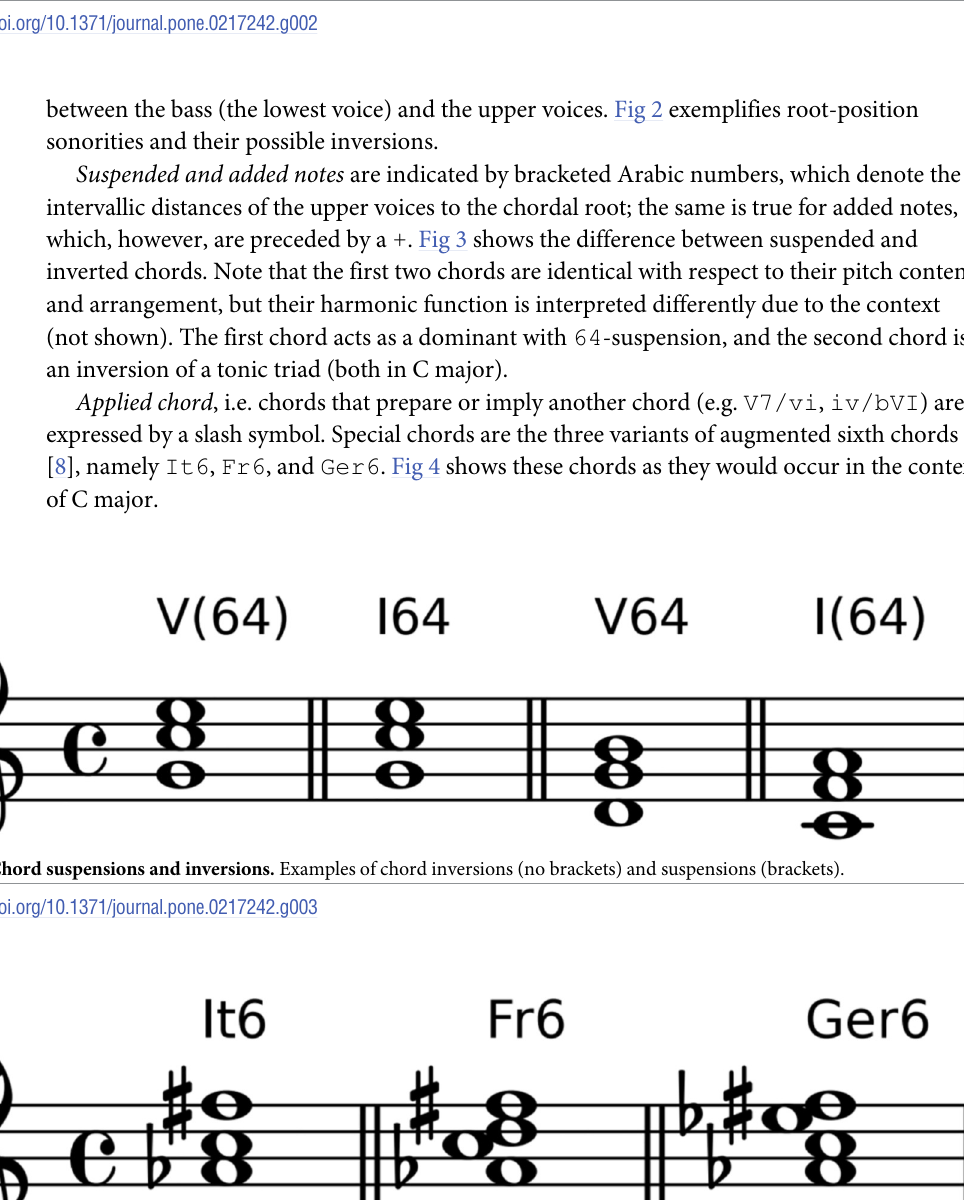
Fig 2. Chord inversions. Examples 1–3 illustrate a root-position chord and its first and second inversion; examples 4–7 show a seventh chord in root position and its first, second, and third inversion.